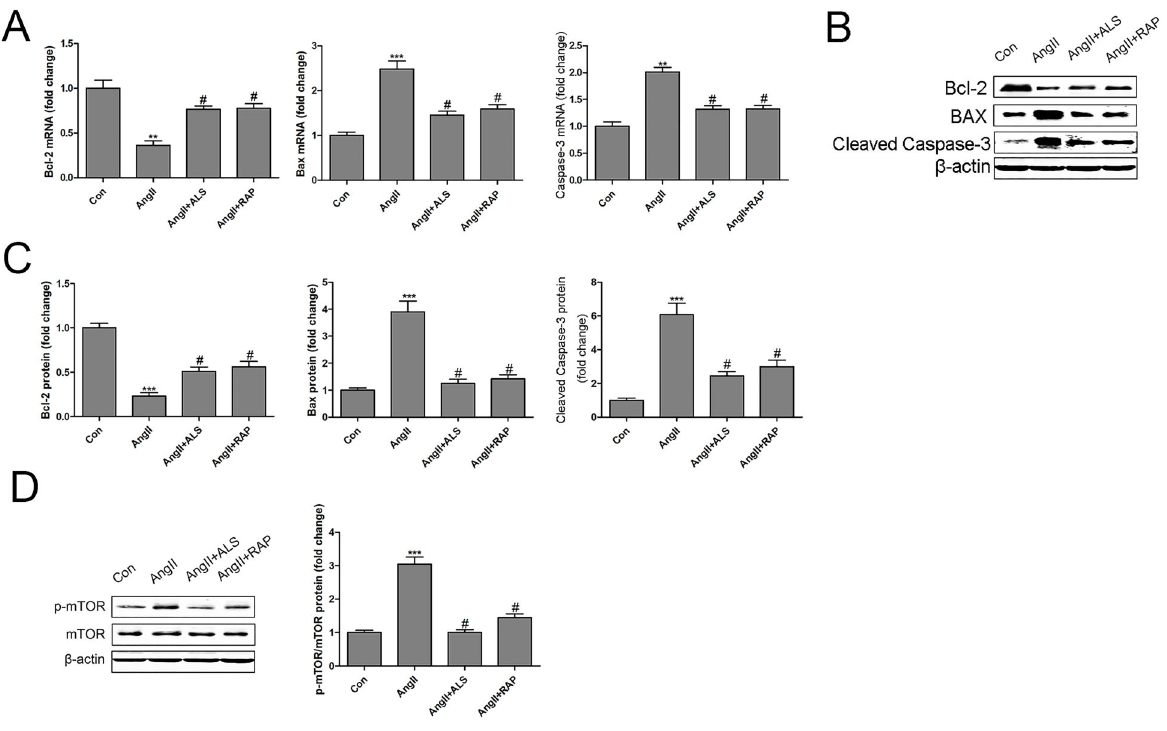
Figure 7. Aliskiren (ALS) inhibited the mTOR and apoptosis pathways in Ang II-treated H9C2 cardiomyocytes. The mRNA expression of Bcl-2, Bax, and caspase-3 was measured by RT-qPCR in H9C2 cardiomyocytes after treatment with Ang II (10 m M), Ang II (10 m M) + ALS (20 m M), or Ang II (10 m M) + RAP (100 nM) for 48 h (n=3 per group) ( A ). The protein expression of Bcl-2, Bax, and cleaved caspase-3 was measured by western blotting ( B and C ). The protein expression of mTOR and p-mTOR was measured by western blotting in H9C2 cardiomyocytes after treatment with Ang II (10 m M), Ang II (10 m M) + ALS (20 m M) or Ang II (10 m M) + RAP (100 nM) for 48 h ( D ), n=3 per group. Data are reported as means ± SE. **P o 0.01, ***P o 0.001 compared with control; # P o 0.05 compared with the Ang II-treated group (ANOVA followed by Tukey ’ s post hoc test). mTOR: mammalian target of rapamycin; Ang: angiotensin; RAP: